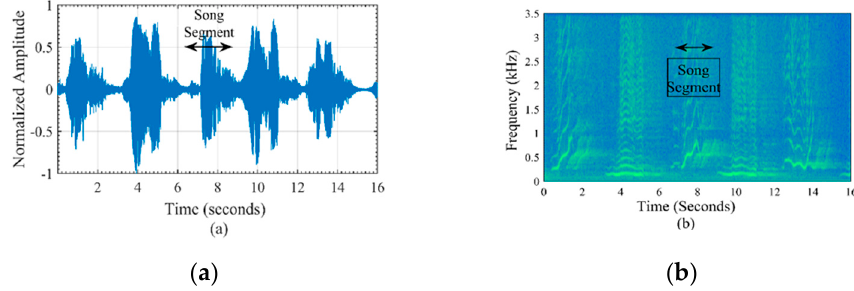
Figure 1. Humpback whale song phrase in ( a ) time and ( b ) frequency domain.